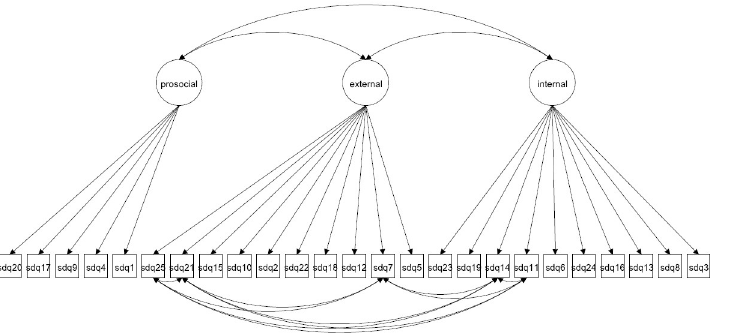
Fig 4. 3-factor model with correlated errors for method effects (Model 2c).